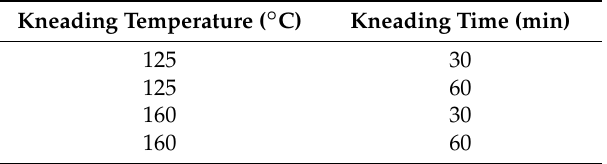
Table 2. Kneading settings for fiber length measurements.